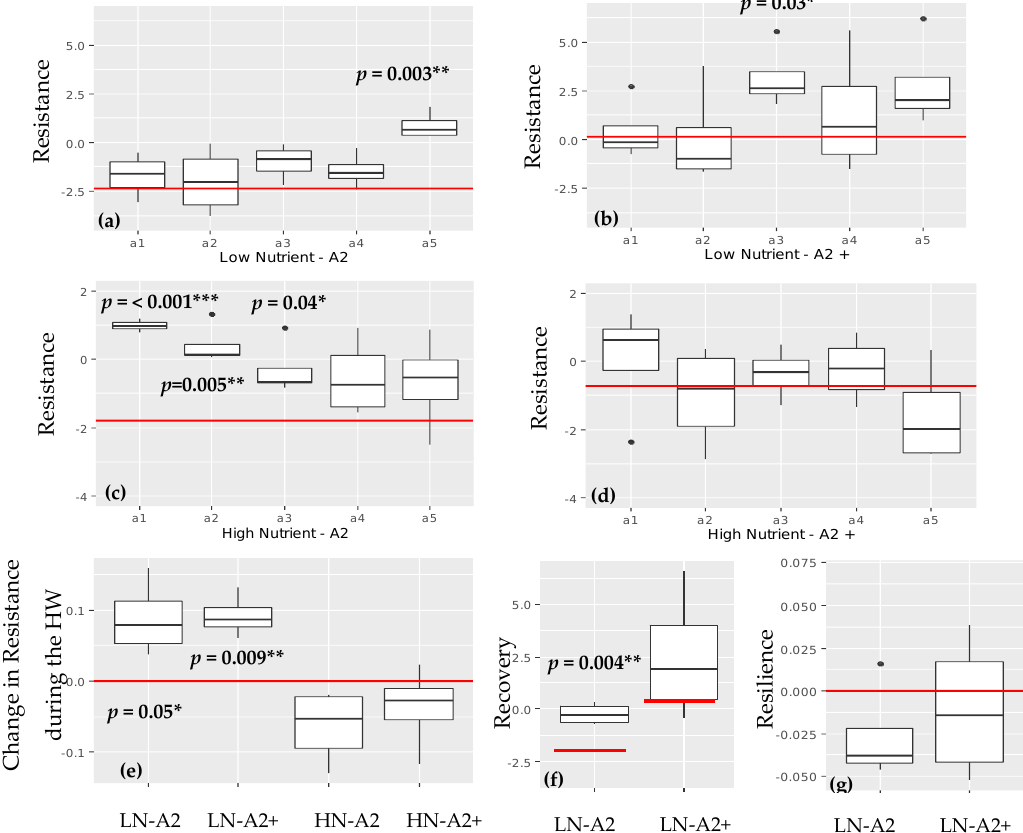
Table 3. p values of size class (SC) LMMs within HN (bold values indicate p < 0.05, heat wave period (during) is highlighted). Figure 6. Resistance, resilience, and recovery of phytoplankton total biomass. Resistance during the HW of five dates (a1:02.07, a2: 07.07, a3: 14.07, a4:21.07, a5:28.07) is shown for four treatments: ( a ) LN-A2, ( b ) LN-A2 + , ( c ) HN-A2, and ( d ) HN-A2 + . ( e ) The change in resistance during the HW for the four treatments (LNA2, LNA2 + , HNA2, HNA2 + ). ( f ) Recovery for LN-A2 and LN-A2 + at the last sampling day. ( g ) Resilience for LN-A2 and LN-A2 + at the last sampling day. Red lines are the benchmarks. p values ( p < 0.05: (*), p < 0.01: (**), p < 0.001: (***)) above the boxplots show significant di ff erences from benchmarks analyzed with one sample t-tests (boxplots are presented with medians and ‘hinges’ are versions of the first and third quartiles). Size Class 1: <5 µm